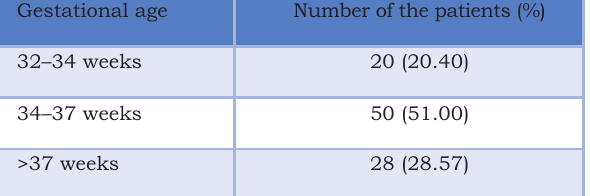
Table 3: Gestational age Gestational age Number of the patients (%)